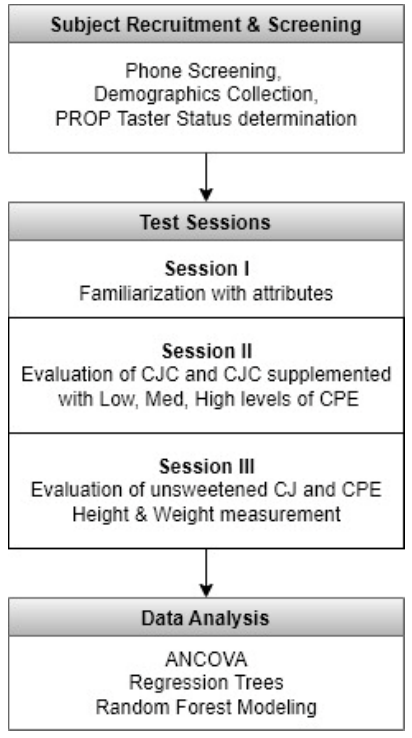
Figure 1. Experimental Procedure.